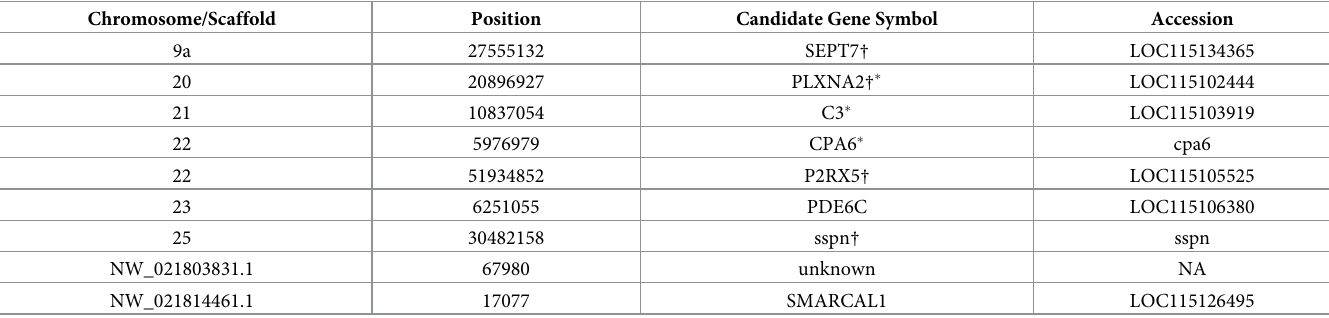
Table 2. Significant eigenGWAS underlying Fraser River kokanee and sockeye ecotypes.